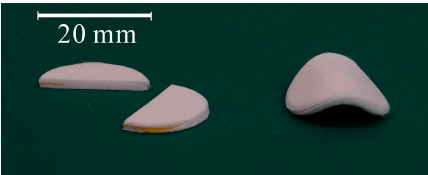
Figure 1. Cut and bent samples. Samples with a density of 0.64 g/mL were cut or bent.